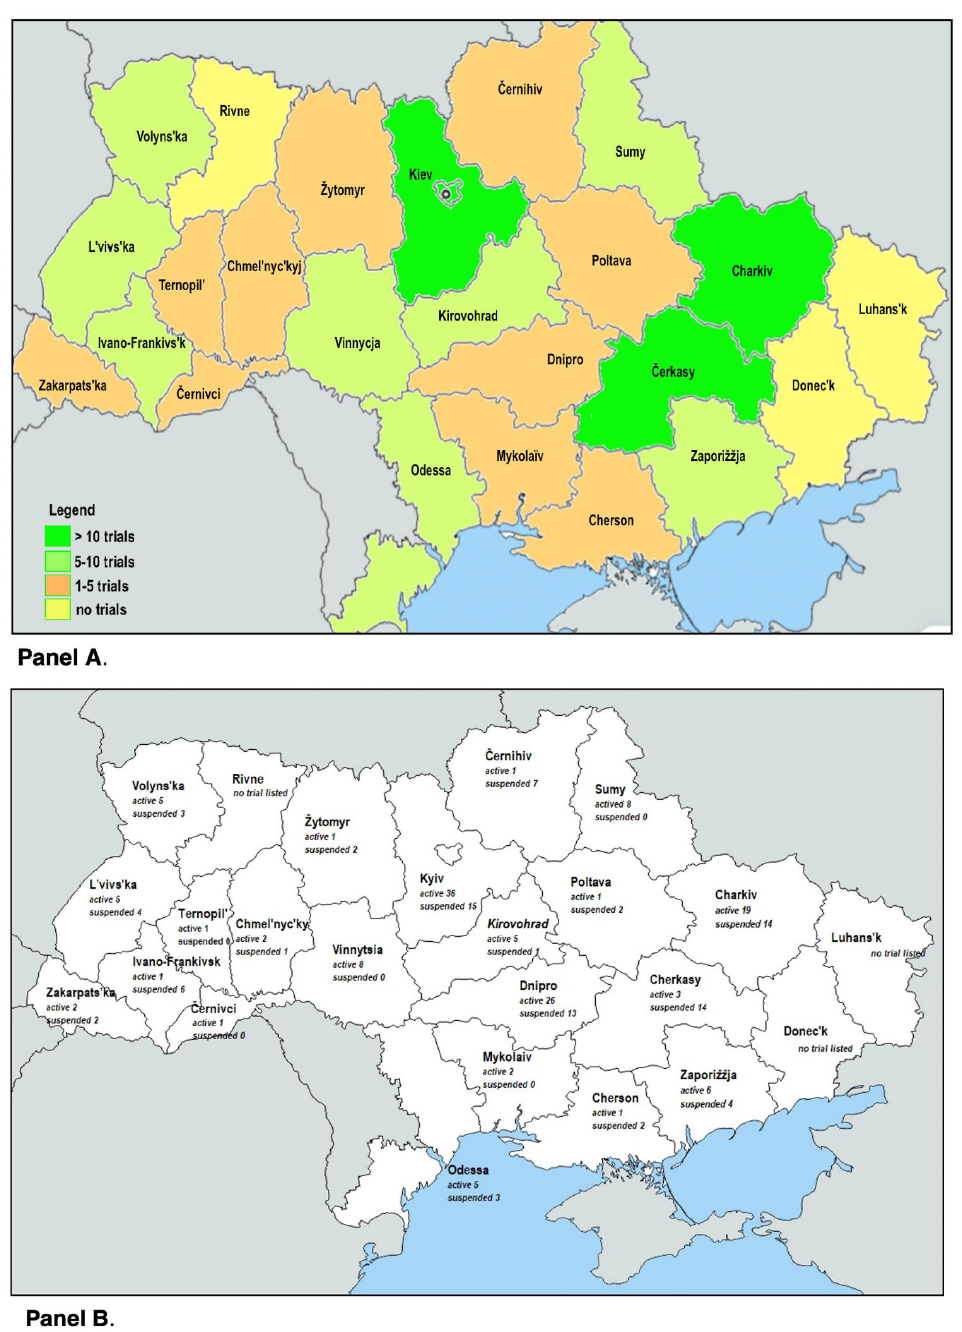
Figure 1. ( A ) Map according to trials grouped by following classes: >10; 5 – 10; 1 – 5. ( B ) Number of trials according to status for each Ukrainian oblast’ as of 5 May 2022.